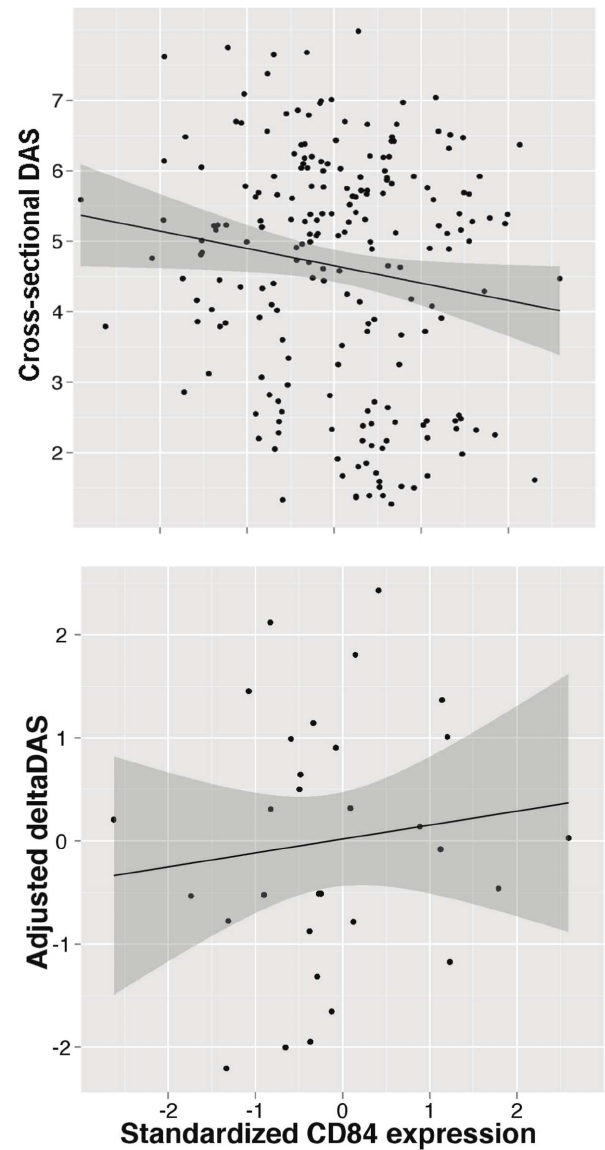
Figure 4. CD84 expression level and clinical features. Analyses are shown in RA patients from the BRASS and ABCoN registries, for baseline DAS (top panel, n=210; R 2 =0.02, p=0.02) and D DAS (bottom panel, n=31; R 2 =0.001, p=0.46). Best-fit linear regression lines are shown in black, with shaded regions showing linear regression model (slope and intercept) 95% confidence intervals. CD84 expression levels were quantile normalized, and D DAS values were adjusted for age, gender and baseline